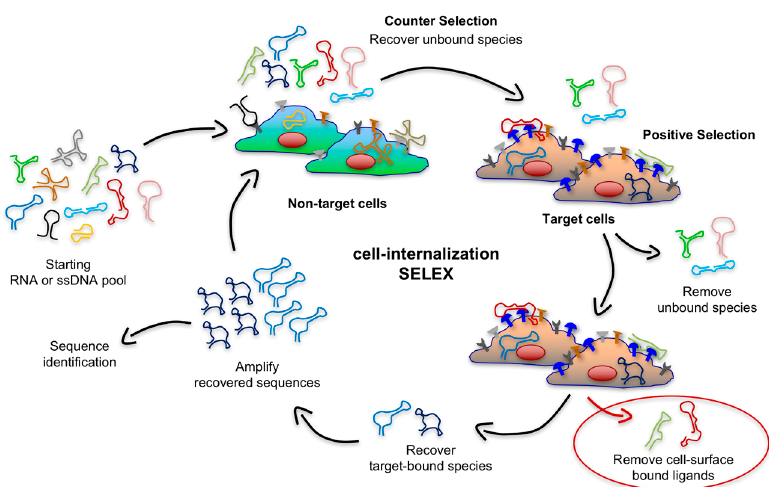
Figure 4. Schematic illustration of the cell-internalization SELEX. This modified selection protocol aims at selecting nucleic acid ligands that are able to both bind cell-surface antigens (depicted in blue) and their ability to rapidly internalize into the cell under physiological conditions, while effectively eliminating aptamers that lack internalizing ability and aptamers that only slowly internalize into the cells because of the target they bind.